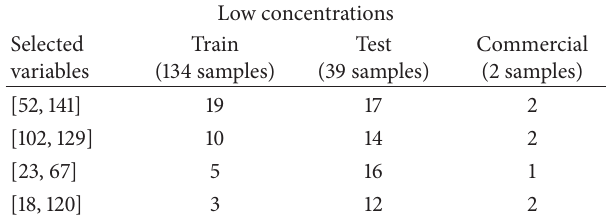
Table 11: Classification errors using GA + ANN: low